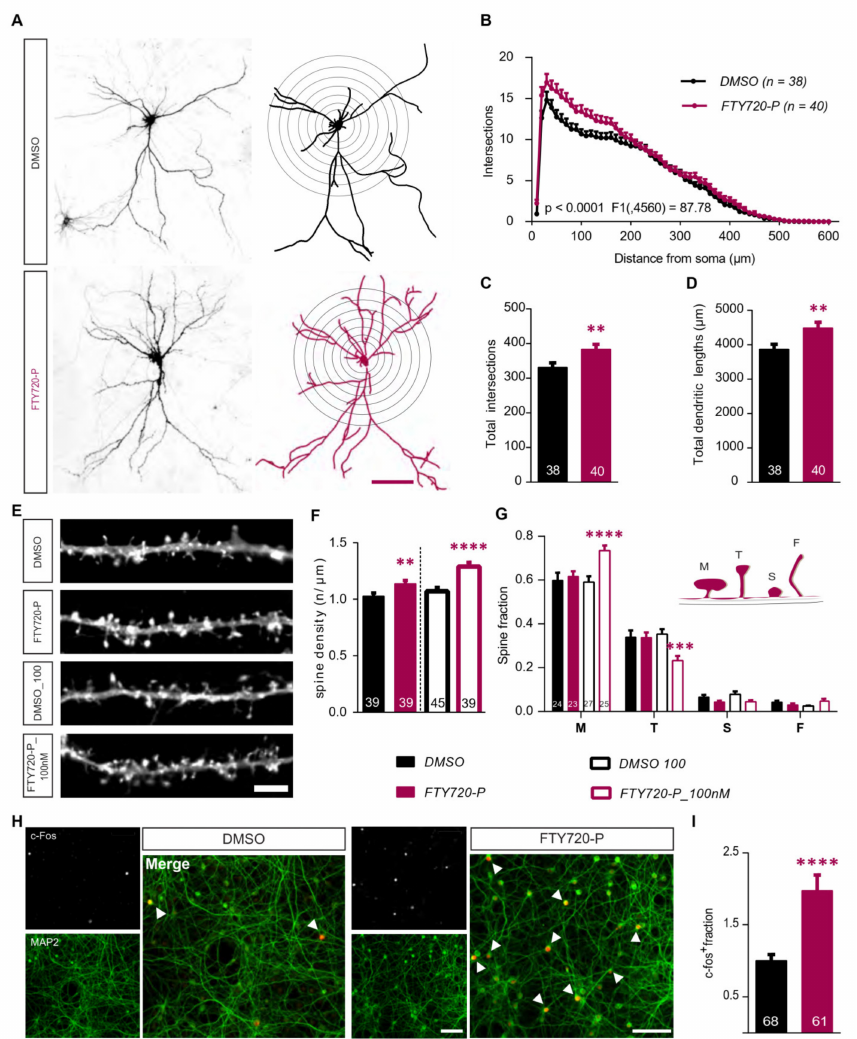
Figure 1. Fingolimod-phosphate (FTY720-P) modulates neuronal morphology in mature hippocampal neurons. FeGFP expressing 21DIV primary hippocampal neurons from healthy wild type BL / 6J mice were treated with 10nM FTY720-P for 24h. ( A ) Representative images (left) of feGFP expressing neurons treated with DMSO (above, black) and 10nM FTY720-P (below, magenta) and the relative Neurolucida tracing used to perform the Sholl analysis (right). Scale bar: 100 µ m. ( B ) Sholl analysis displaying dendritic complexity plotted against distance from the cell soma. F value refers to the DMSO v / s FTY720-P comparison. The graphs show ( C ) the total dendritic complexity and ( D ) total lengths of dendrites for the DMSO (black) and FTY720-P (magenta) treated neurons. ( E ) Representative segments of secondary dendrites from feGFP transfected neurons used to analyze dendritic spine density. Scale bar: 5 µ m ( F ) Graphical representation of the spine density for neurons treated with 10 (magenta solid) or 100nM (magenta open) FTY720-P their respective DMSO controls (10nM black solid; 100nM black open). ( G ) the graph shows the distribution of di ff erent dendritic spine types across all treatment groups. The four di ff erent types of spines– mushroom (M), thin (T), stubby (S) and filopodia